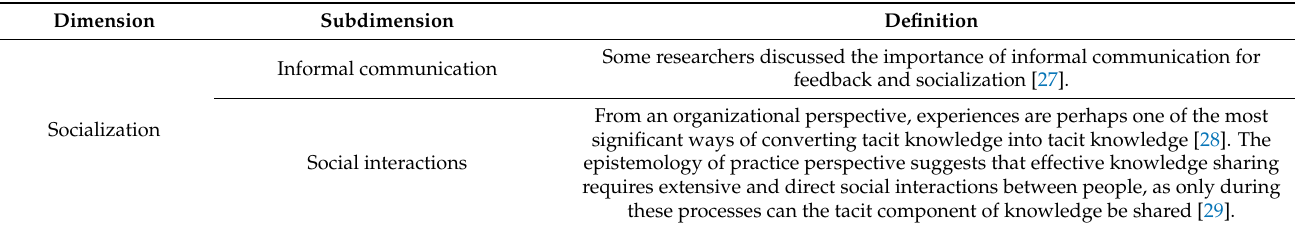
Table 1. The socialization